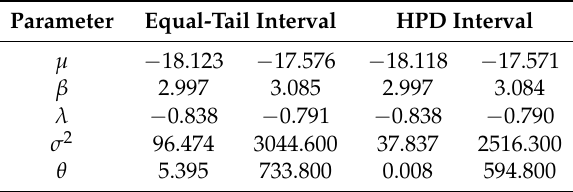
Table 2. 95% Credible Interval of parameters